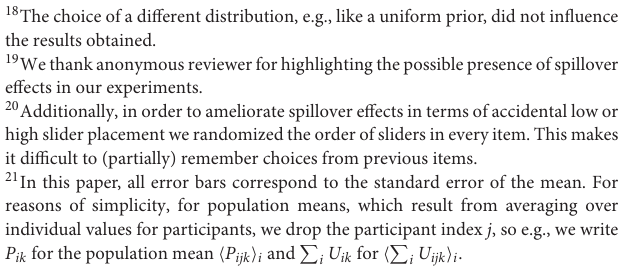
The model predictions on prior probabilities suggest that the model can cope well with the data. The value for the parameter κ is close to one, indicating that normalized slider values map approximately linearly to prior